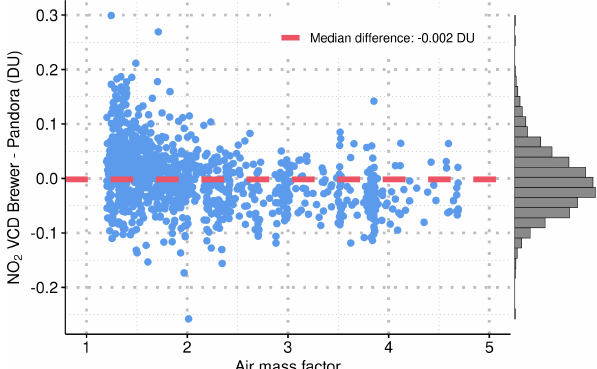
Figure 8. Difference between NO 2 VCD retrievals from Brewer #067 and Pandora #117 as a function of the air mass factor (AMF). The median of the differences ( − 0 . 002DU or − 5 . 4 × 10 13 molec . cm − 2 ) is plotted as a dashed